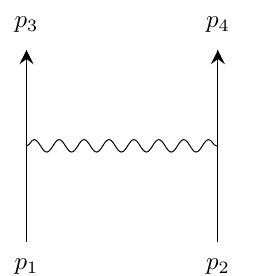
Figure 1. Schematic representation of high-energy elastic two-to-two scattering. The internal line represents the Pomeron kernel de(cid:12)ned in eq.